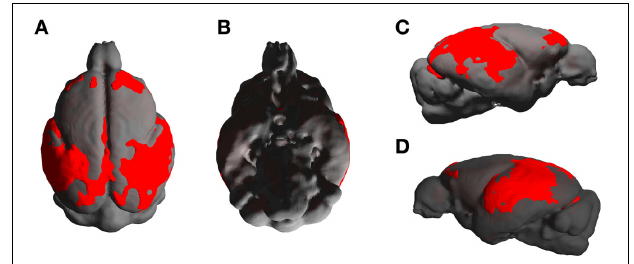
FIGURE 5 | External views [A: dorsal, B: ventral, C,D: lateral (right and left)] outlining age-associated cortical alterations in mouse lemurs.